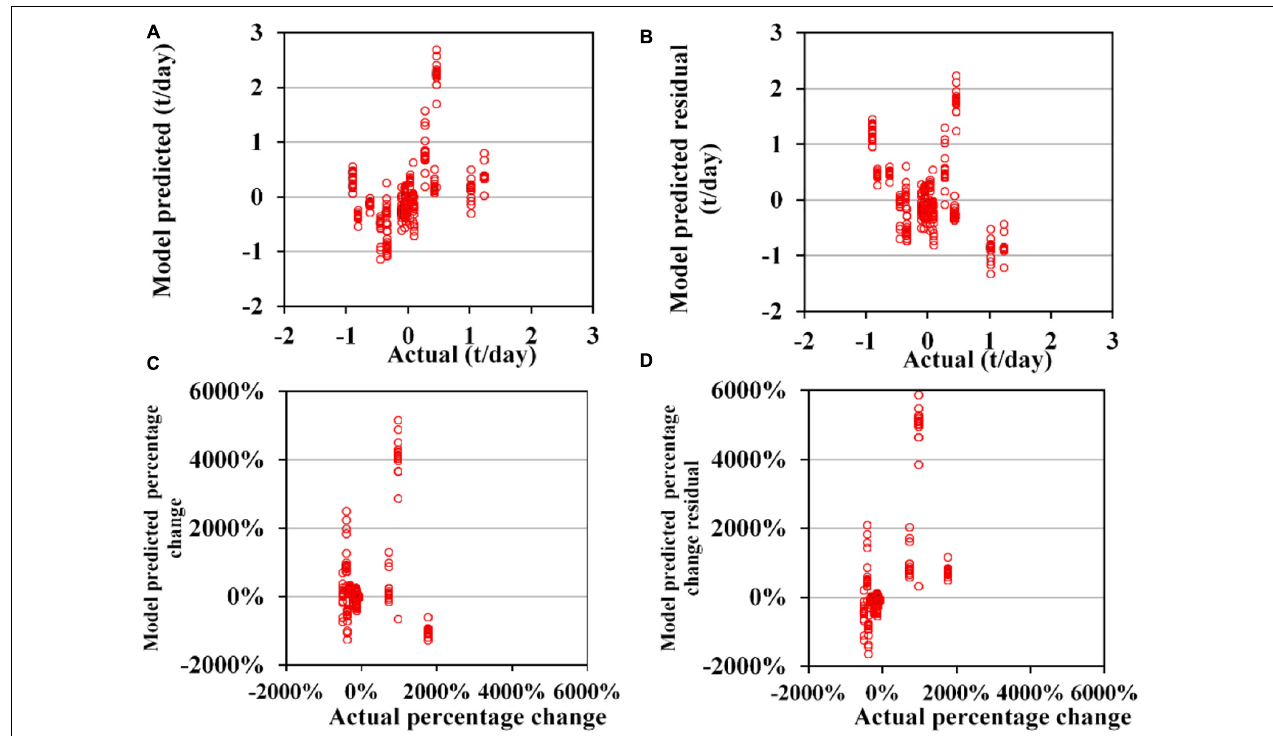
FIGURE 9 | Cross-validation results of 153 sub-models of generalized additive models (GAM) for the annual trend of the abundance of Ommastrephes bartramii (CA). (A) Model-predicted residual and actual CA; (B) residual between model-predicted and actual CA; (C) model-predicted and actual CA percentage change compared with the last year (except for 2003 in which it is compared with the year 2004); (D) the model predicted the residual and actual value for CA percentage change compared with the last